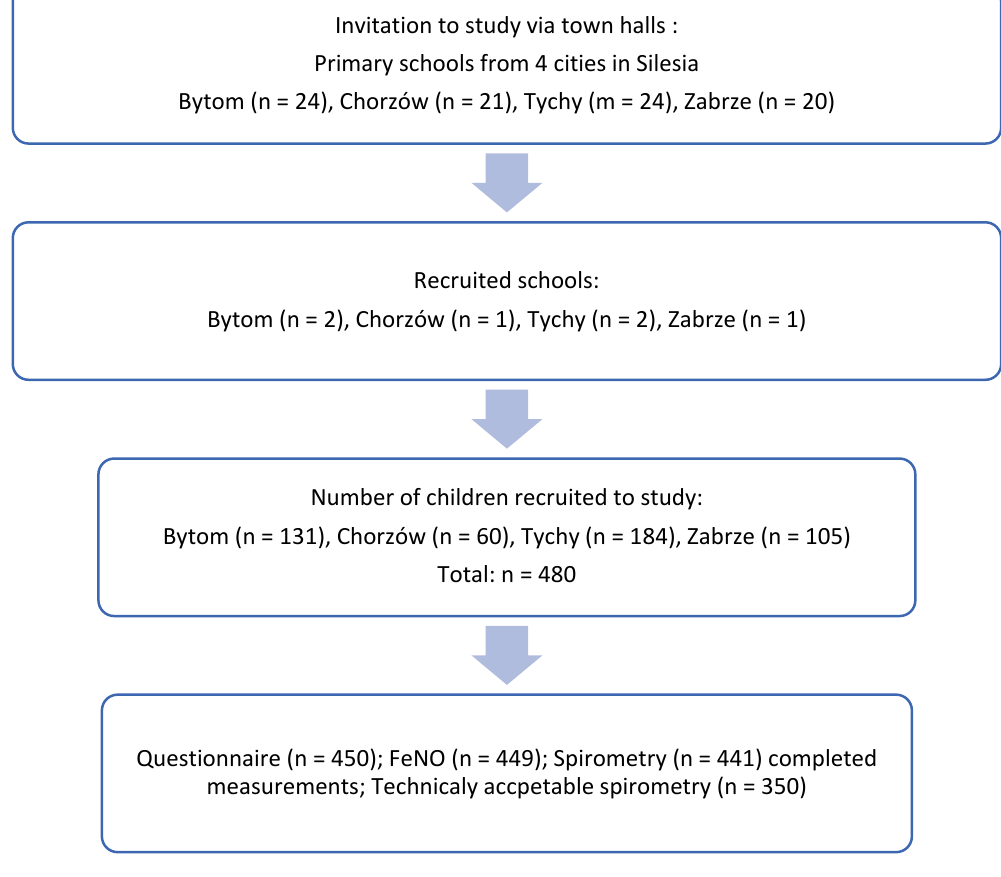
Figure 1. The process of recruitment of children in the study.